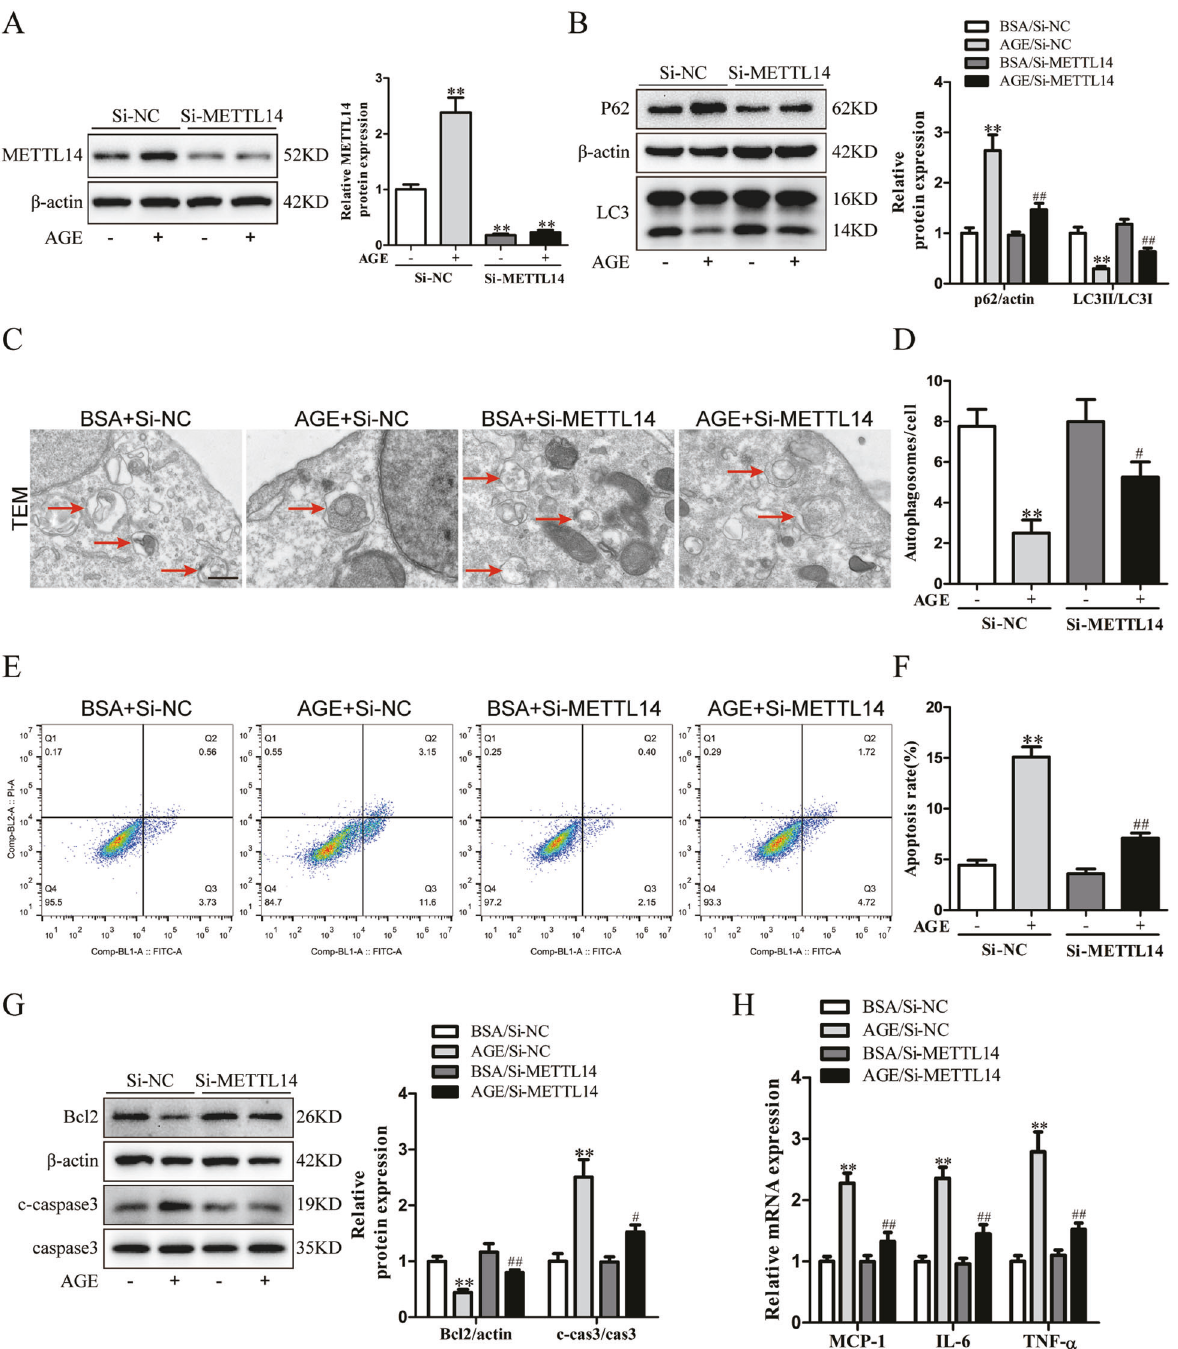
Fig. 6 Gene silencing of METTL14 protected against AGE-induced podocyte injury in vitro. Podocytes transfected with negative SiRNA (SiNC) or METTL14 knockdown SiRNA (SiMETTL14) were administrated with BSA or AGE (50 μ g/ml). A Representative immunoblots and quantitative analysis of METTL14 in different groups of podocytes ( n = 6). B Western blot analysis showing METTL14 knockdown weakened AGE-induced inhibition of P62 degradation and LC3-I to LC-3II conversion in podocytes ( n = 6). C , D Representative electronic micrographs and quantitative analysis showing METTL14 silencing ameliorated the reduction of typical autophagosomes in podocytes induced by AGE treatment. Scale bar, 500 nm ( n = 4). E , F Apoptosis of podocytes with different treatments analyzed by fl ow cytometry. The results showed that METTL14 knockdown downregulated the percentage of apoptotic podocytes in AGE-treated podocytes ( n = 6). G Western blot analysis of apoptosis-related proteins (Bcl2 and cleaved caspase3) in podocytes with different treatment ( n = 6). H Quantitative RT-PCR analysis showing the reduction of in fl ammatory cytokines (MCP-1, IL-6 and TNF- α ) mRNA levels with METTL14 inhibition in AGE-treated podocytes ( n = 6). ** P < 0.01 vs. BSA + SiNC group, # P < 0.05, ## P < 0.01 vs. AGE + SiNC group. Data are presented as mean ± SEM.